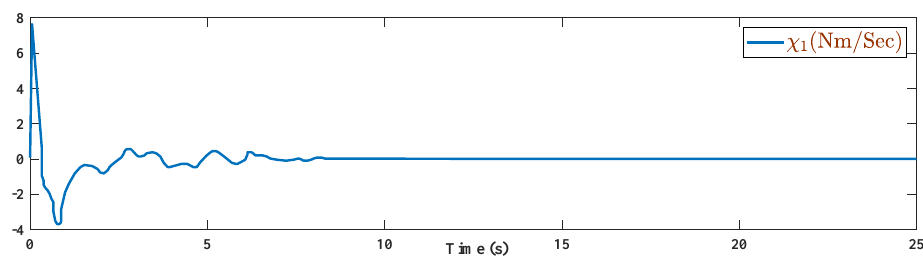
Figure 14. Time response of x 1 related to Scenario 2.